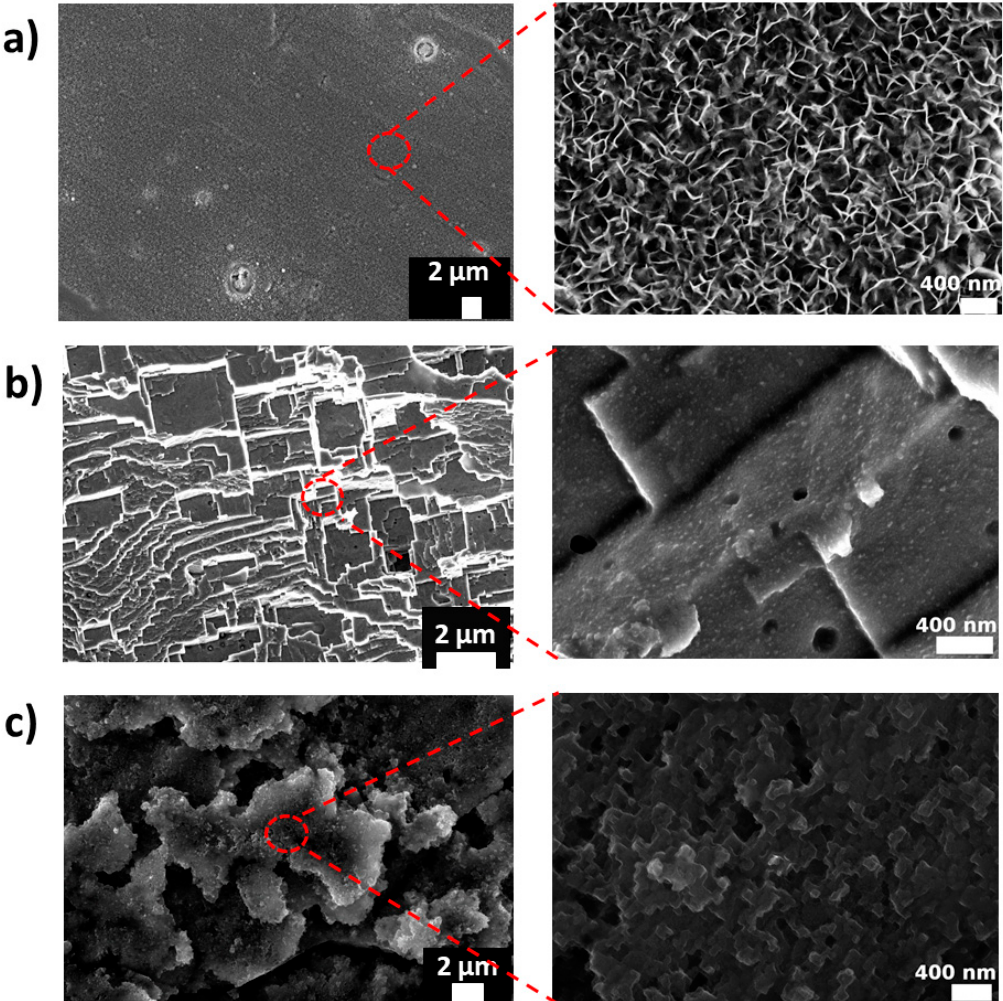
Figure 1. Low-magnification and high-magnification SEM images of aluminum alloy sample prepared by ( a ) boiling (A_WS), ( b ) HNO 3 /HCl etching (A_NS), and ( c ) HF/HCl etching (A_FS).